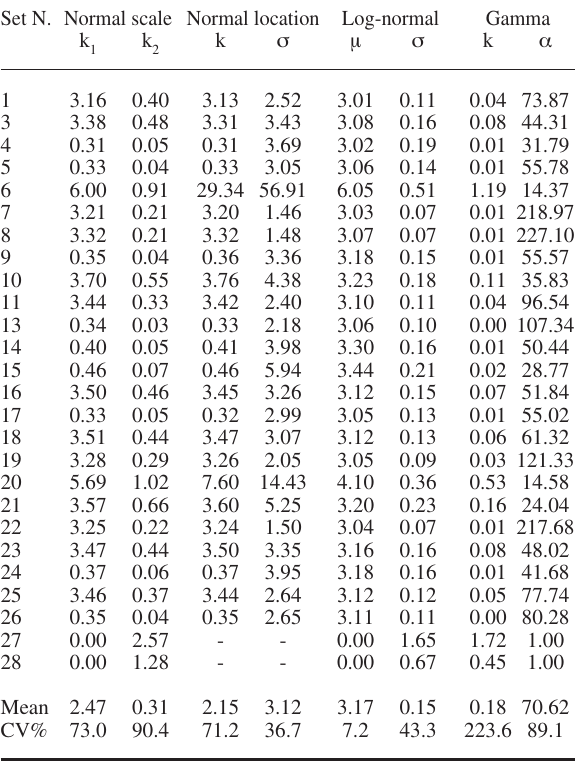
Table 6 . – Uni-modal selection curve parameters for individual sets and mean values with the correspondent Coefficient of variation (Cv%). Cv<100: low variance; Cv>100: high variance. Set N. Normal scale Normal location